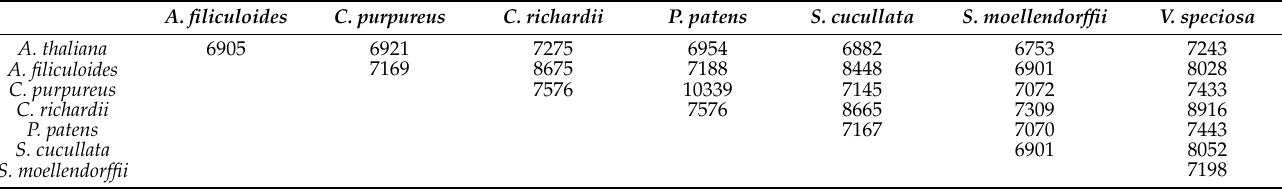
Table 5. Number of shared orthogroups between V. speciosa and the rest of